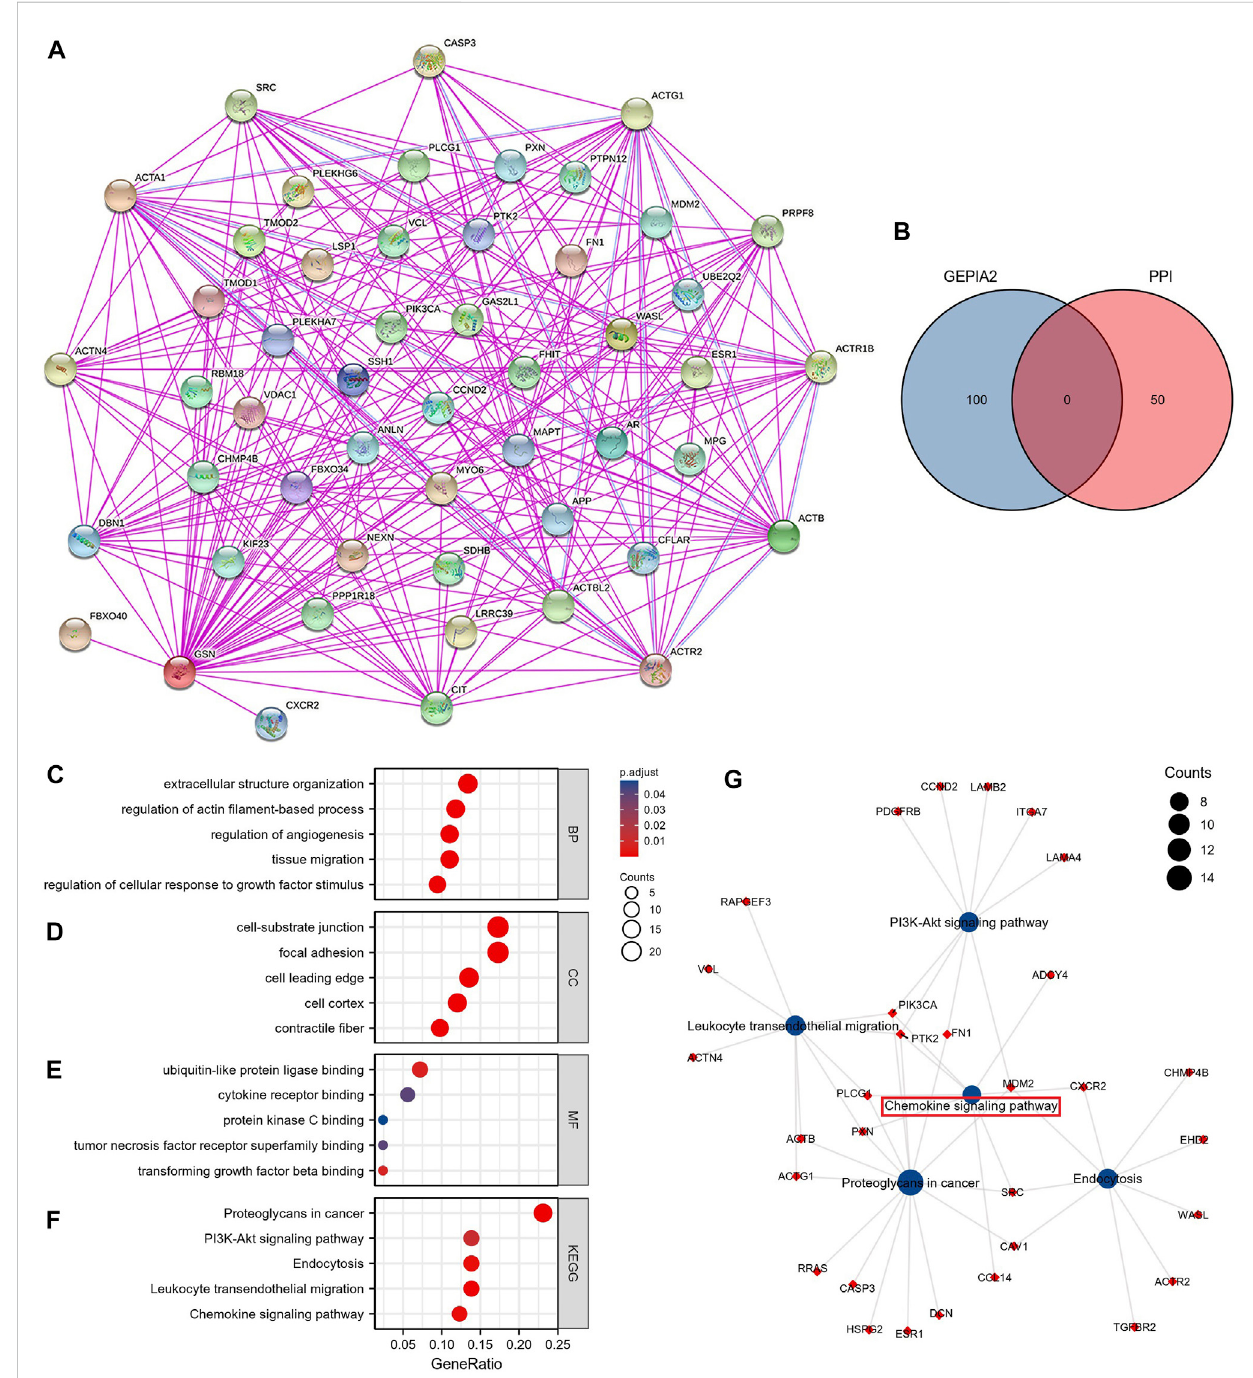
FIGURE 12 GSN-related genes, interacting proteins and functional enrichment analysis. (A) PPI Network for GSN. (B) The intersection of GSN-binding and interacting genes after selection by Venn diagram analysis. GO analyses, including biological process (C) , cellular component (D) , molecular function (E) , and KEGG pathway (F) . (G) Visual network of KEGG